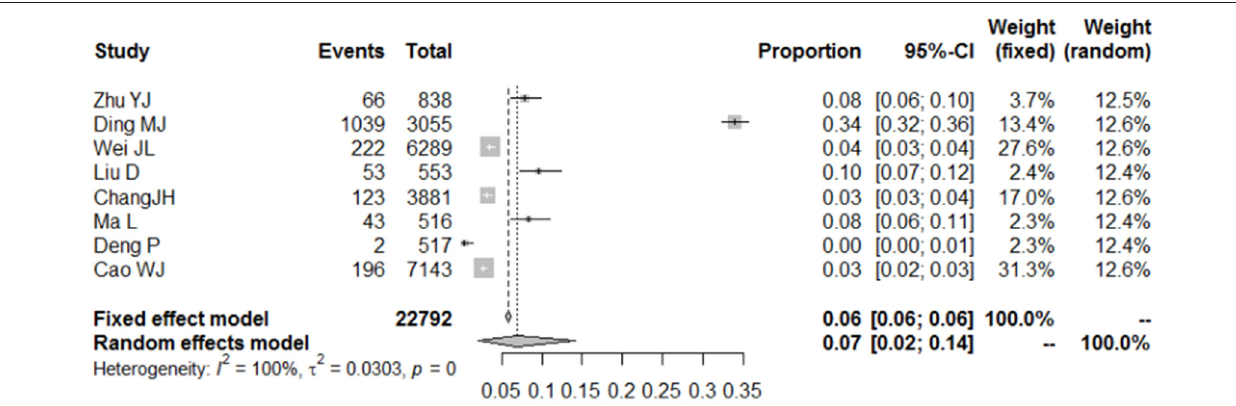
FIGURE 4 | Forest plot of the incidence of mild depression among college students during